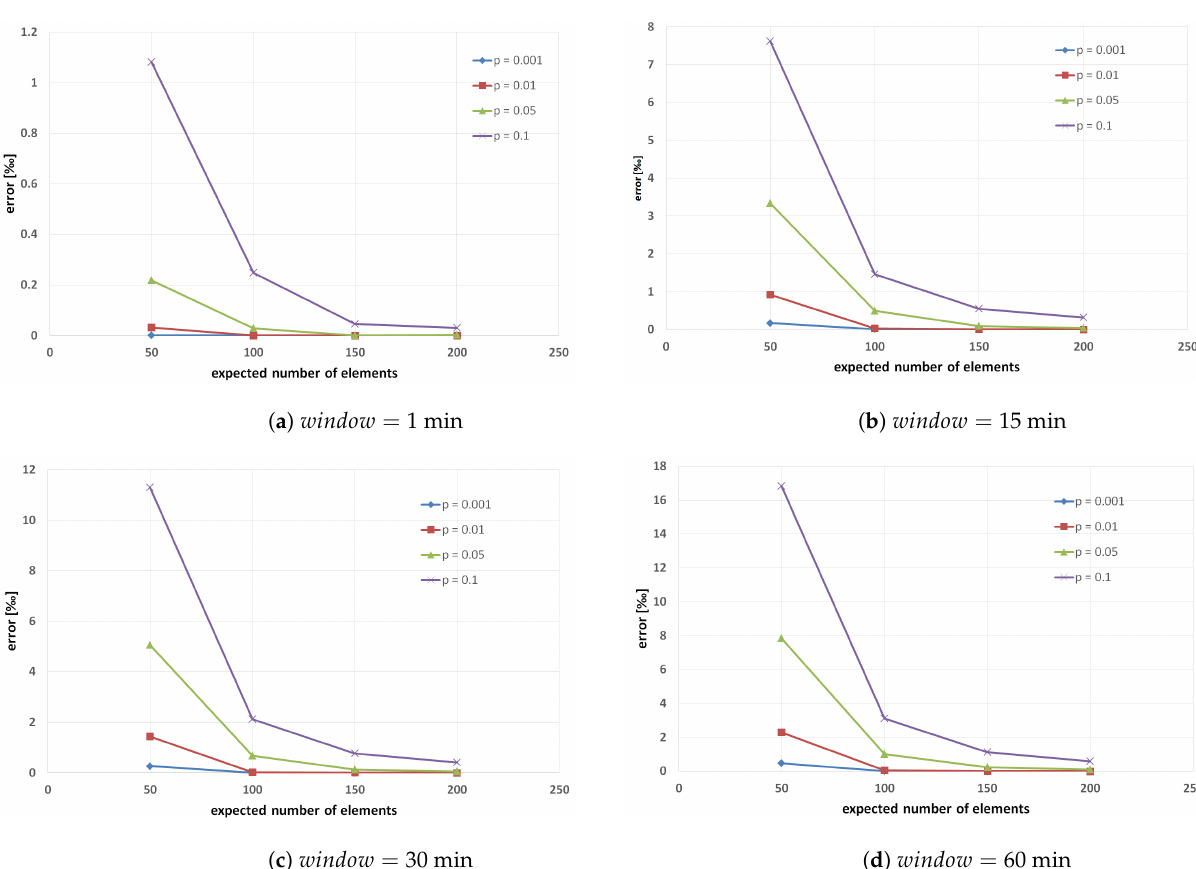
Figure 6. Percentage of elements that were lost during a 24 h period for different BF validity